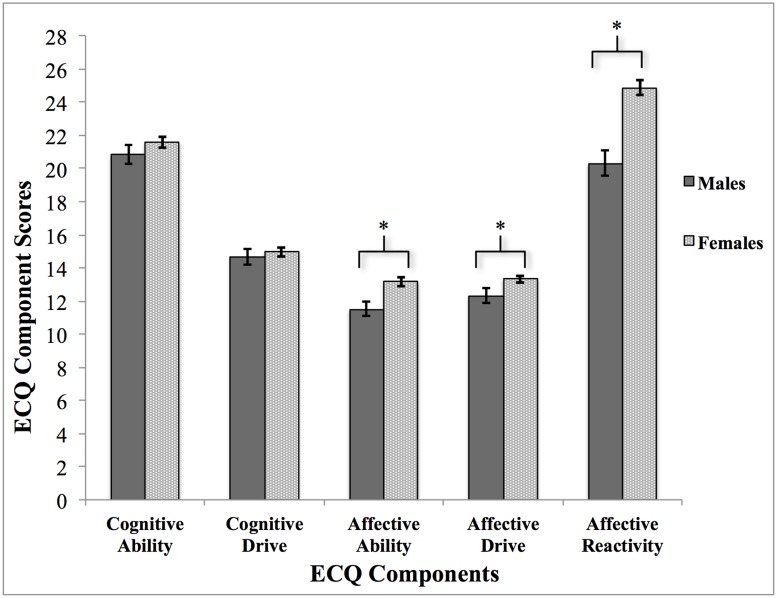
Assessment of sex differences across the preliminary five components extracted from the ECQ in 101 participants.